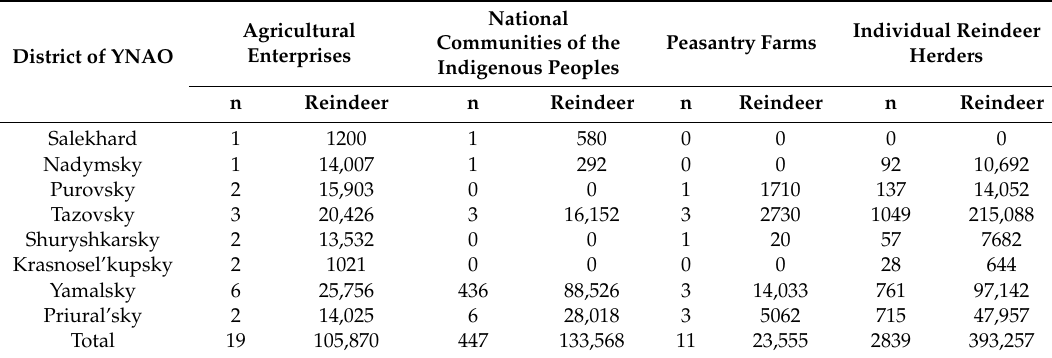
Table 2. Agricultural enterprises, national communities, peasantry farms and individual reindeer herders in YNAO* (on 1 January 2020).